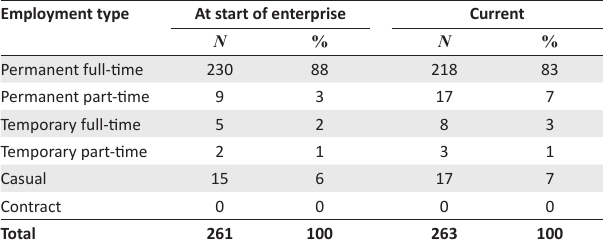
TABLE 3: Change in the type and number of employees since start-up, Diepsloot ( n = 300).